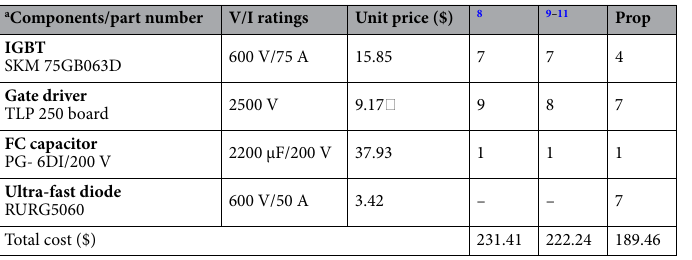
Table 5. Cost comparison of recent 7L boost ANPC type SCMLI topologies. a Mouser.com and